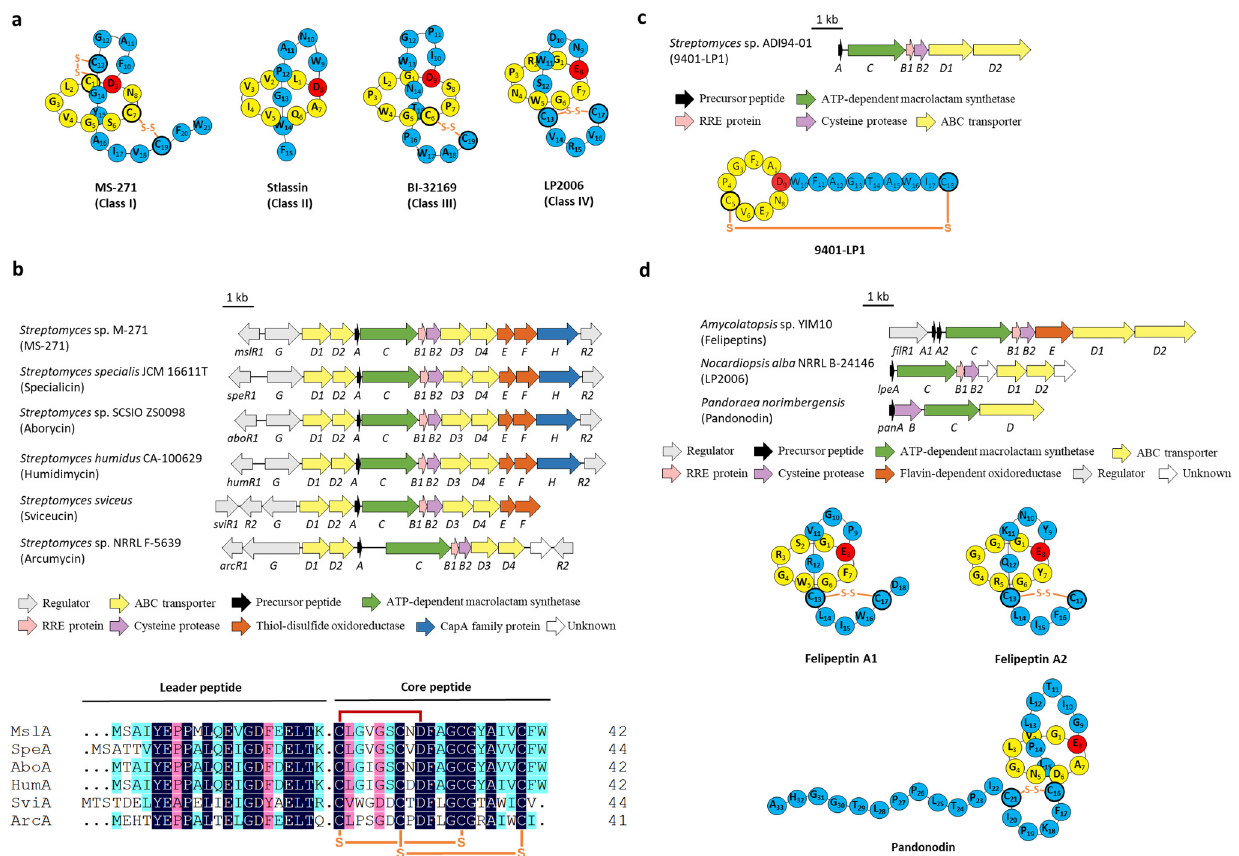
Figure 2. The BGCs and structures of lasso peptides containing disulfide bond(s). ( a ) Representative structures of classes I, II, III, and IV lasso peptides. ( b ) The BGCs of class I lasso peptides and the sequence alignment of the precursor peptides. ( c ) The BGC and structure of class III lasso peptide 9401-LP1. ( d ) The BGCs and structures of class IV lasso peptides.